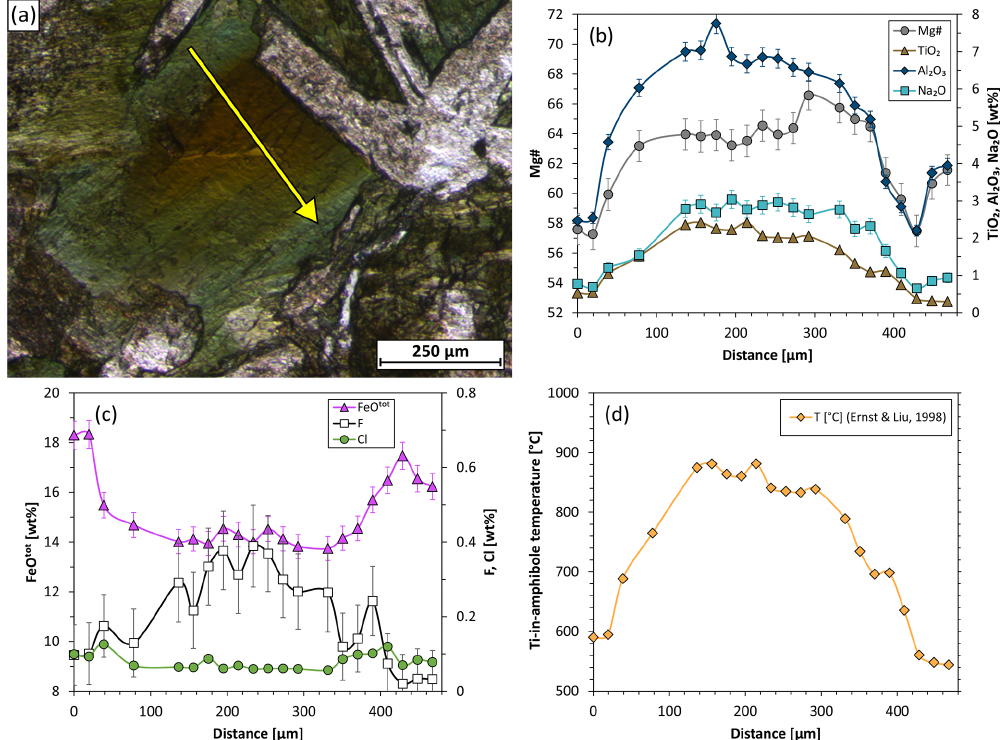
Figure 12. Compositional zoning in an amphibole with a brown core in a typical varitextured gabbro (sample GT3A-109Z-2, 48–56cm). (a) Microphotograph with plane-polarized light with the yellow arrow marking the start and end of the EPMA profile. (b–d) Gradual decrease in Mg#, Al 2 O 3 , Na 2 O, TiO 2 , F and formation temperature from core to rim. (c) Reversed relationship for FeO and Cl. Reported error bars are the count-specific error. Error bars for TiO 2 and Cl are smaller than the symbol